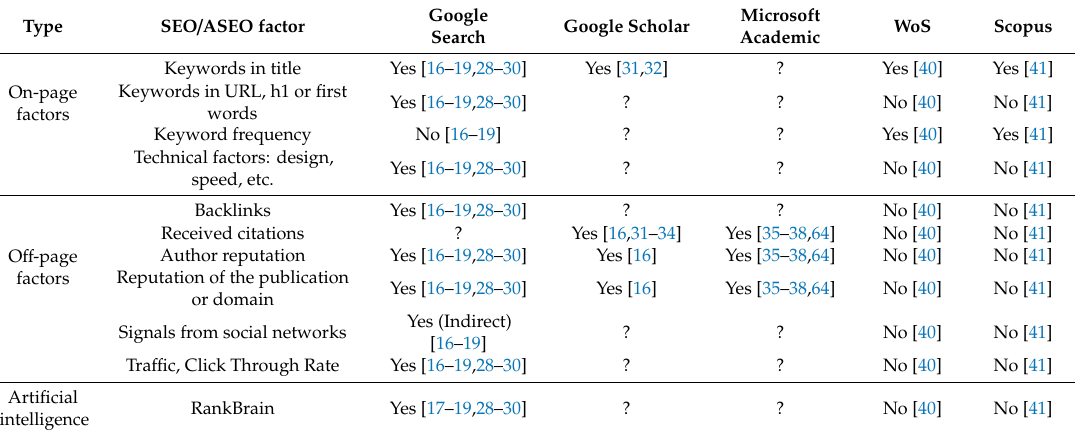
Table 1. Search engine optimization (SEO) and academic search engine optimization (ASEO) factors. WoS, Web of